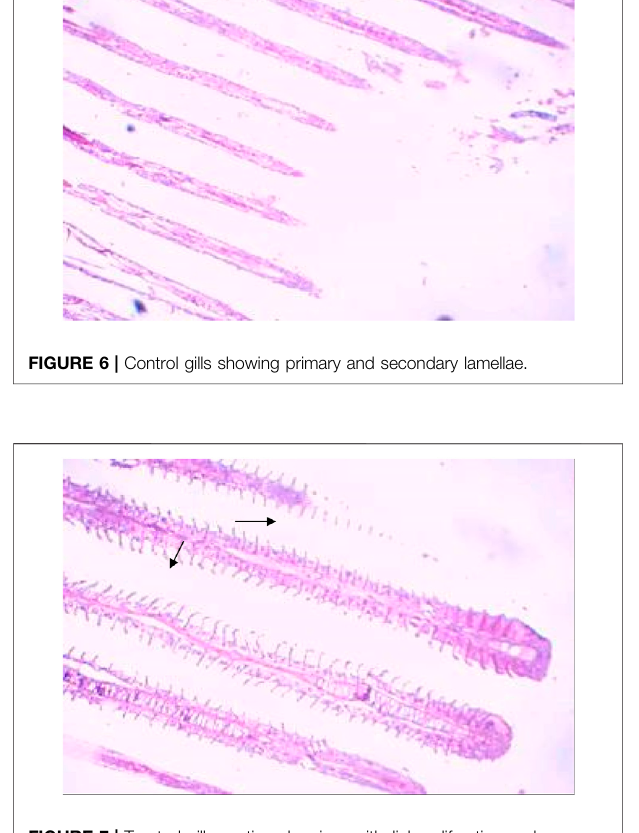
FIGURE 7 | Treated gills section showing epithelial proliferation and congestion.